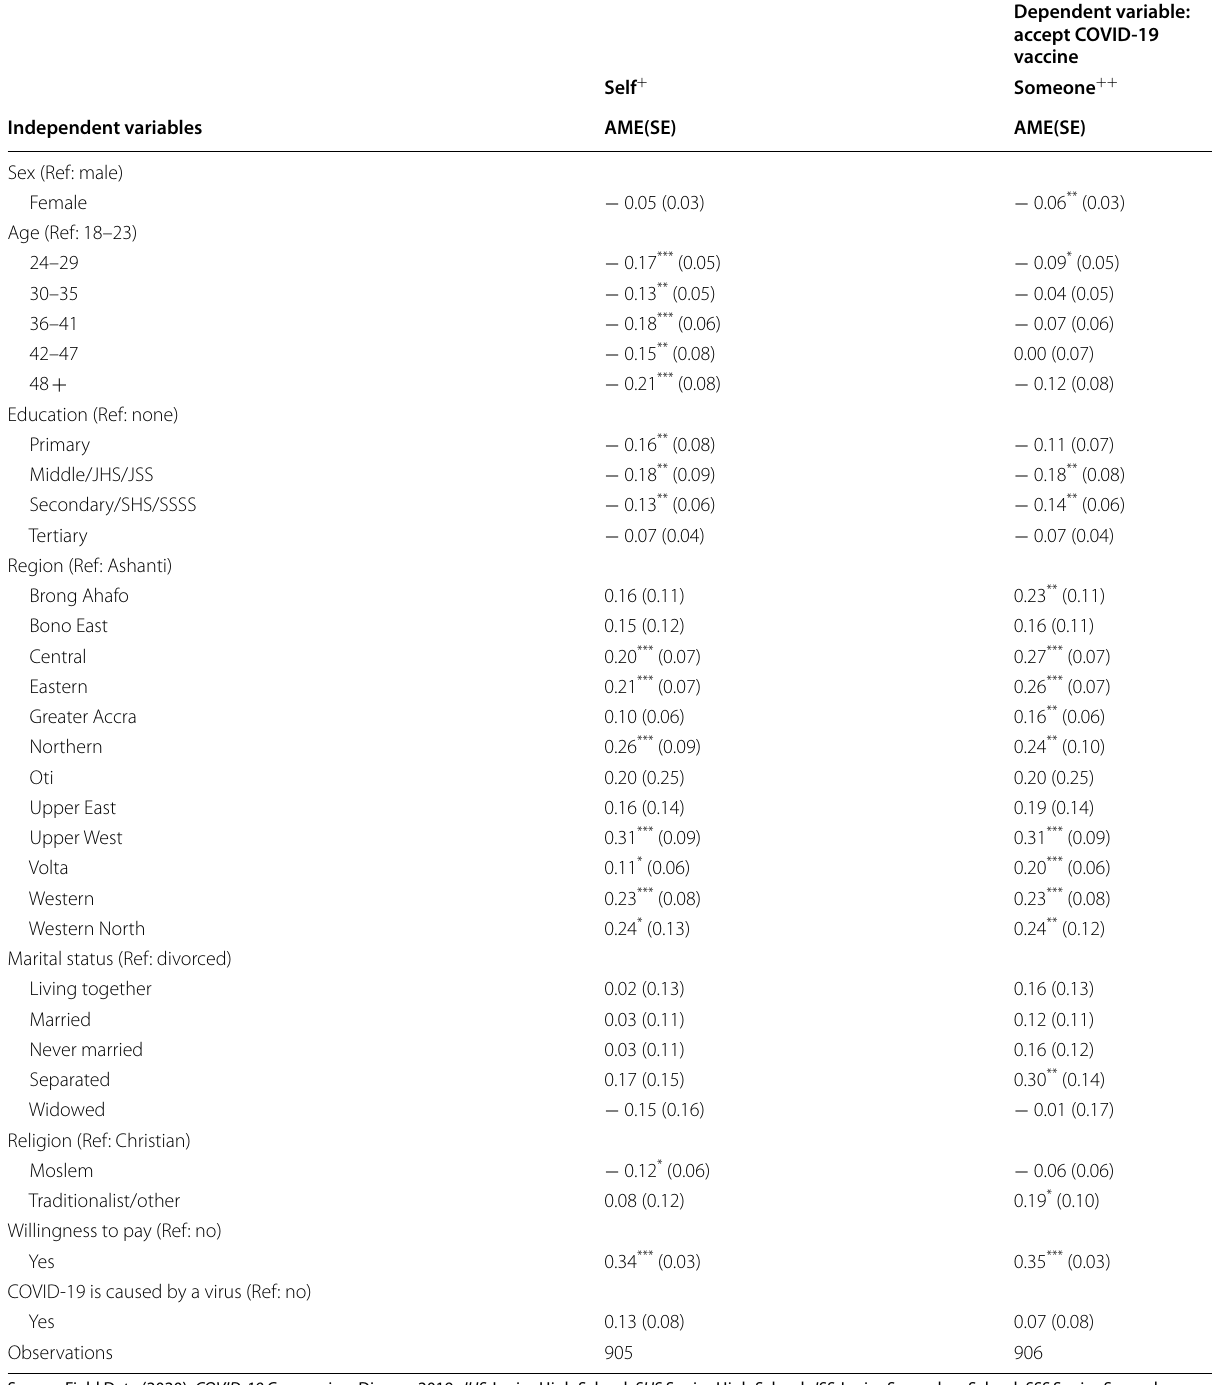
Table 3 Probit regression estimates of determinants of willingness to accept or uptake COVID‑19